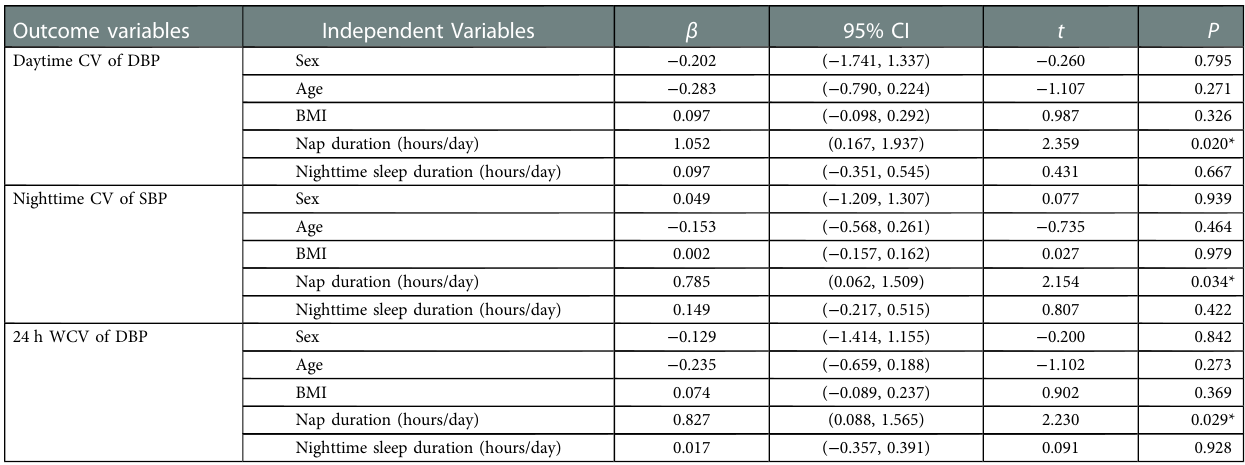
TABLE 3 Multiple linear regression analysis of predictors of